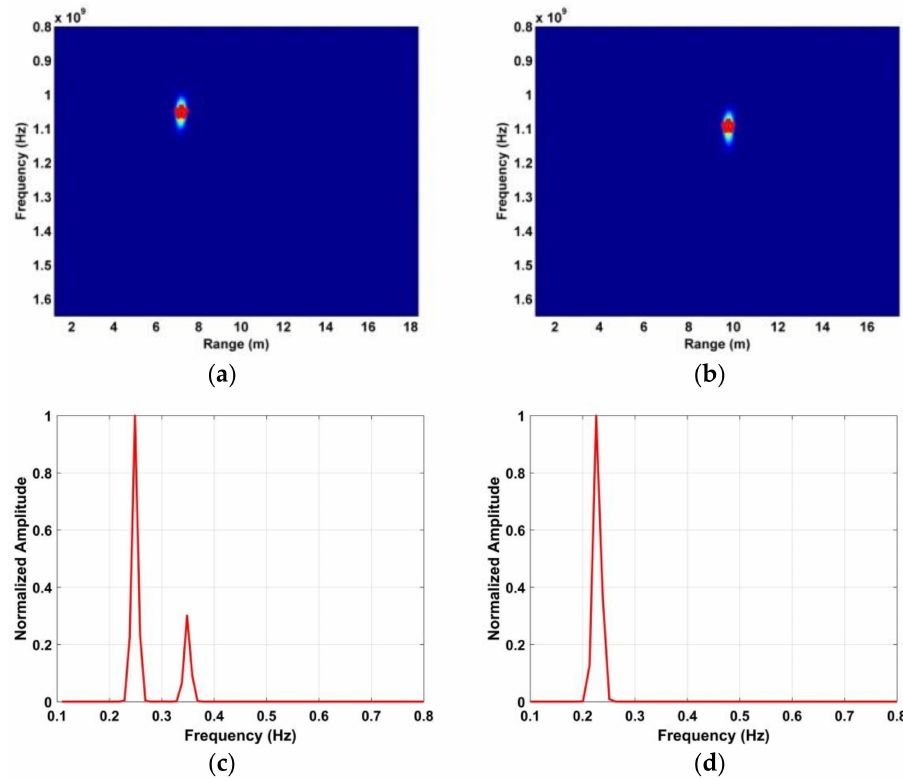
Figure 17. Results after performing the DWFT with indoor data, ( a ) range estimation at 700 cm, ( b ) range estimation at 1000 cm, ( c ) frequency estimation at 700 cm, and ( d ) frequency estimation at 1000 cm.